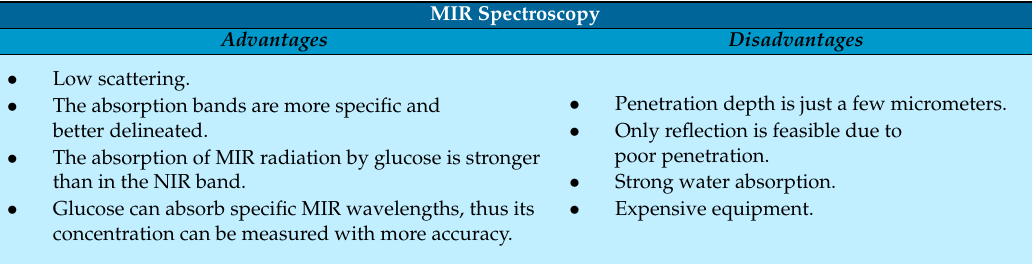
Table 10. Advantages and disadvantages of NIR